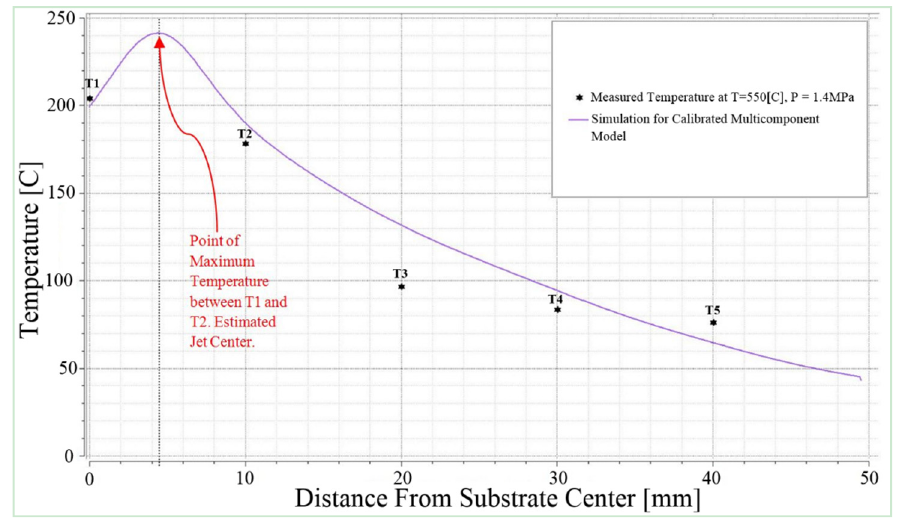
Figure 5. Comparison of experimental results with calibrated 3D multicomponent model thermal outcome for all five thermocouples at 550 °C and 1.4 MPa cold spray conditions.